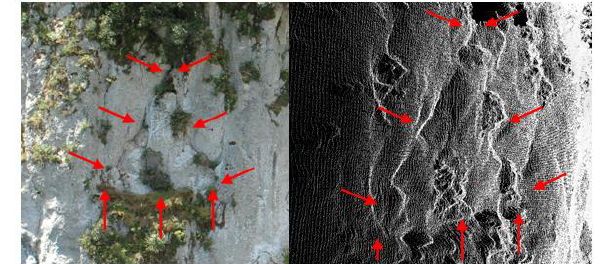
Figure 11. Unstable block identified on a digital image along a rock shoulder of the dam (left) and view of the block on the 3D model rendered using the intensity